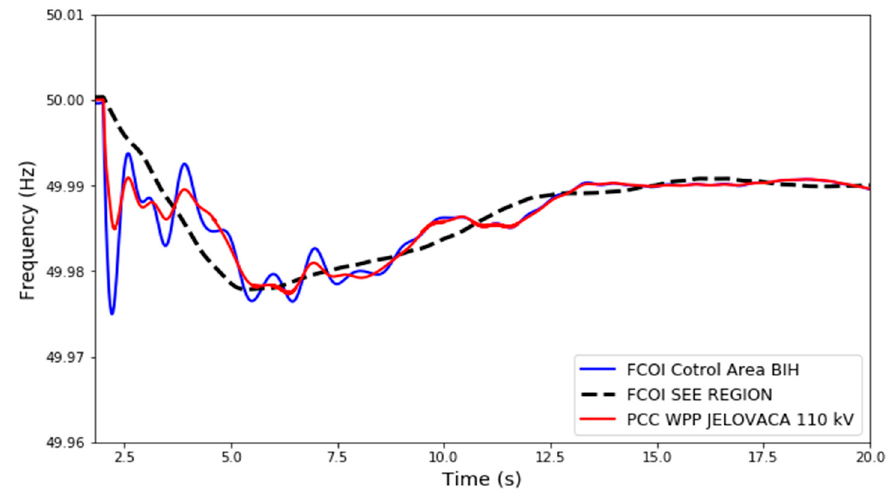
Figure 8. EPS frequency response, time simulation 20 s.